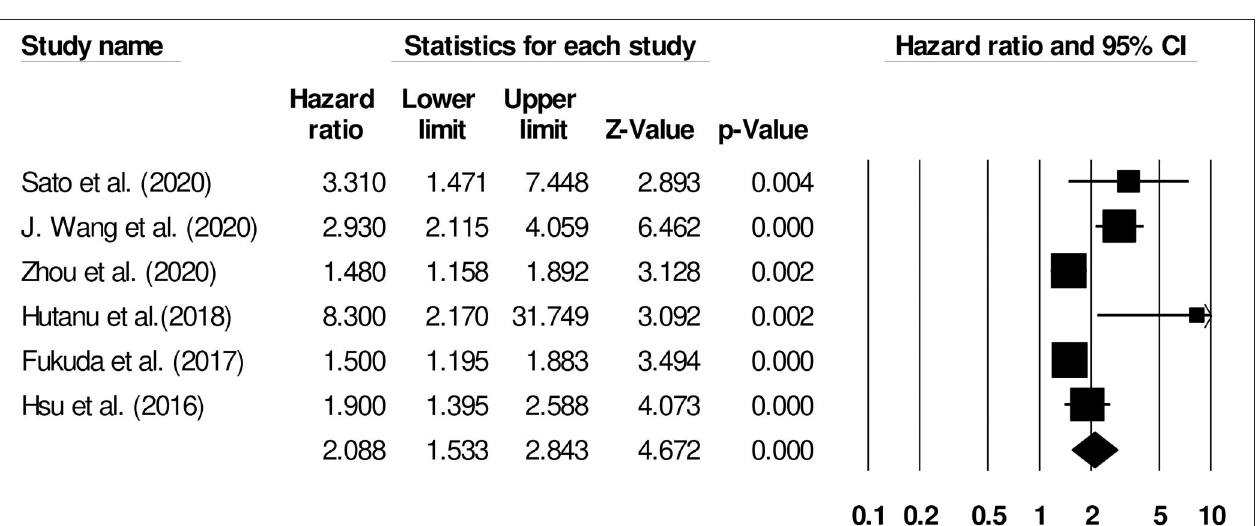
FIGURE 7 | Forest plot for studies evaluating the impact of D-dimer level on post-stroke functional outcomes for 3 months follow up. Hazard ratios are presented as black boxes while 95% confidence intervals are presented as whiskers. A small hazard ratio represents a lower influence of D-dimer levels on stroke patient functional outcome while a higher hazard ratio represents a higher